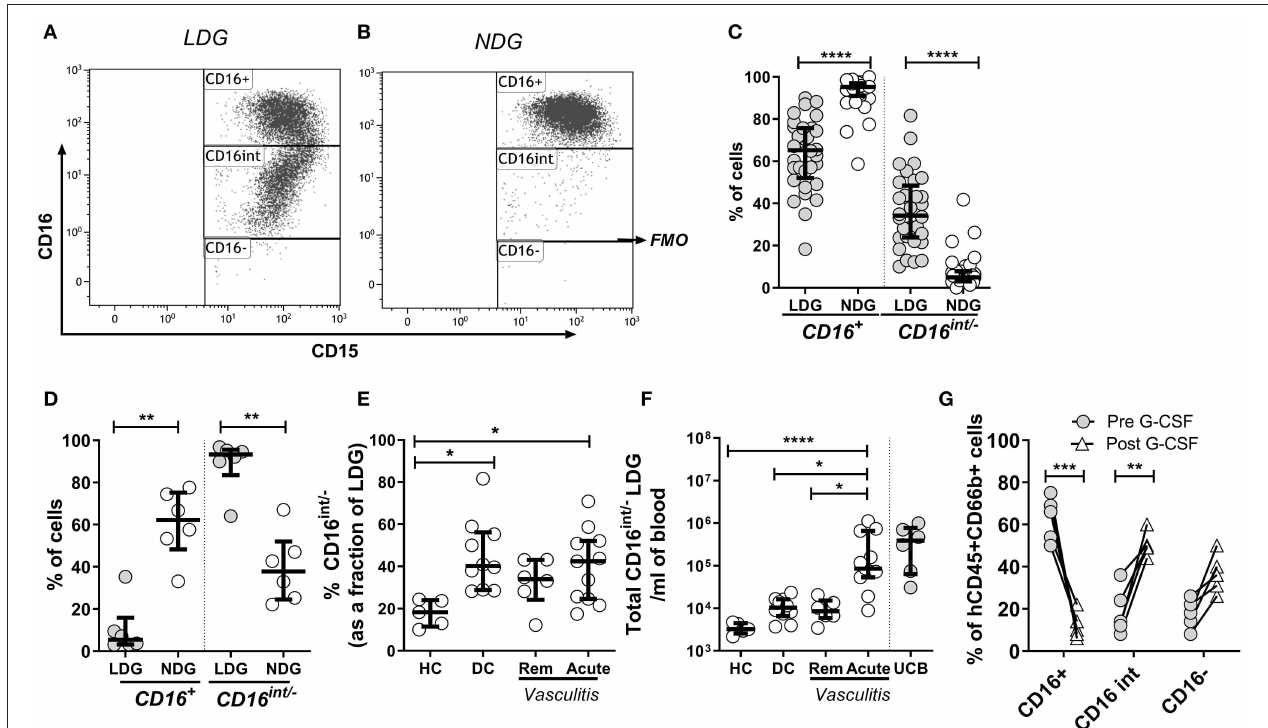
FIGURE 2 | CD16 expression defines subpopulations of LDGs. Mixed leukocyte populations were separated by density centrifugation; LDGs and NDGs were classified as SSC hi CD15 + CD14 − singlets in the low density (PBMC) and high-density layers, respectively. LDGs and NDGs were categorized as CD16 + , CD16 int and CD16 − (FMO, fluorescence minus one), with a representative LDG sample illustrated in (A) . A representative NDG sample is shown in (B) . Most NDGs were CD16 + , whereas approximately one third of LDGs were CD16 int / − (C) Wilcoxon ranked sum test . For comparison, virtually all LDGs in UCB were CD16 int / − (D). The percentage (E) and absolute number (F) of CD16 int / − cells in the LDG fraction was compared across disease phenotypes. ANOVA with post hoc Tukey’s multiple comparison test, * p < 0.05, ** p < 0.01, *** p < 0.001, **** p < 0.0001. Administration of G-CSF to mice ( n = 5) with a humanized immune system caused dramatic reduction in peripheral blood CD16 + neutrophils, with an associated increase in CD16 int / − neutrophils. 2-way ANOVA and Sidak’s multiple comparison test ** p < 0.01, *** p < 0.001 (G) .